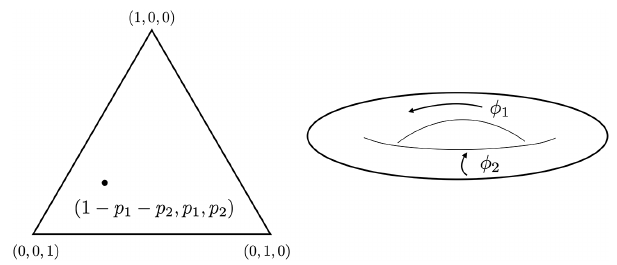
FIG. 2. Quantum state space of a qutrit. Left: a finite- dimensional quantum system with D = 3 represented in two dimensions. Section III noted that canonically conjugated coordi- nates allow considering the full quantum state space as a classical two simplex (cid:10) 2 , which represents the space of classical probabil- ity distributions ( 1 − p 1 − p 2 , p 1 , p 2 ) . Right: a two-torus T 2 that accounts for the nontrivial phases (φ 1 , φ 2 )